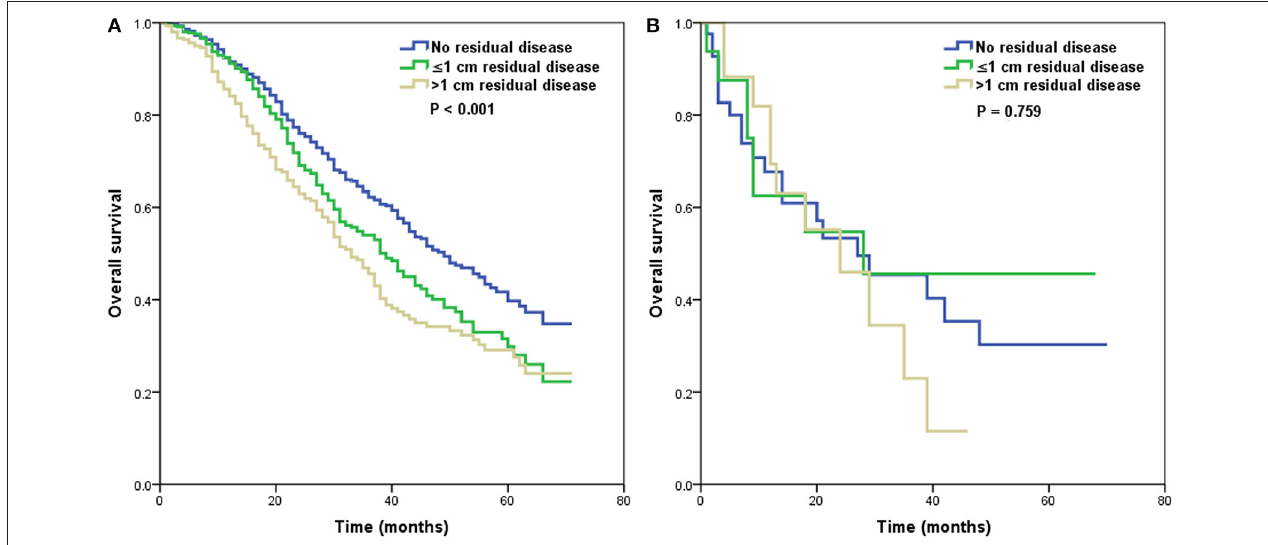
FIGURE 3 | Survival curves of residual tumor size by the specificity of histological subtypes [ (A) , high-grade serous and endometrioid subtypes; (B) , mucinous and clear cell